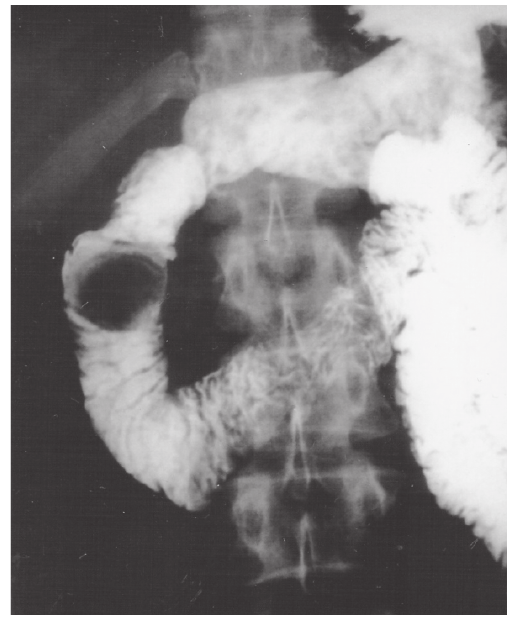
Figure 1- Contrasted radiography of the small intestine showing a defect in the radiologic filling in the second part of the duodenum. Note the well- defined and regular area with preservation of the mucosal folds.